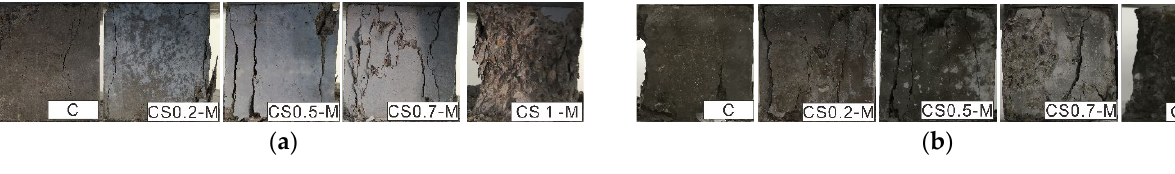
Figure 4. Compressive strength destruction appearance; erosion for ( a ) 180 d and ( b ) 360 d.